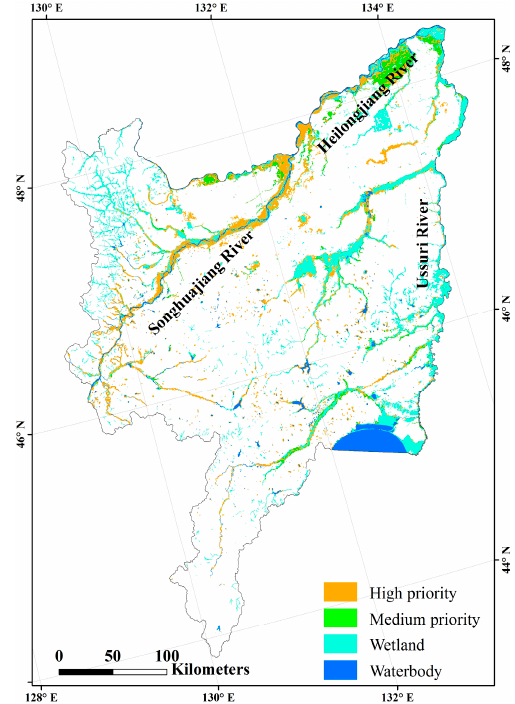
Table 3. Cropland areas in the eight Wetland National Nature Reserves (WNNR) in the SJP.